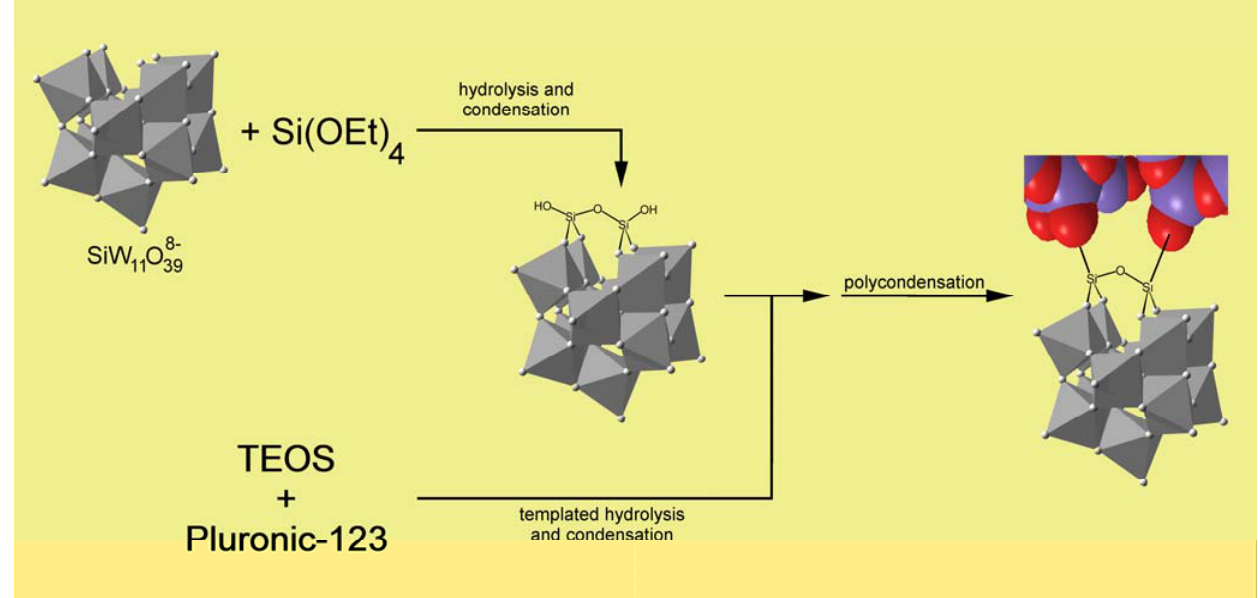
O 398- and covalent bonding with the 11